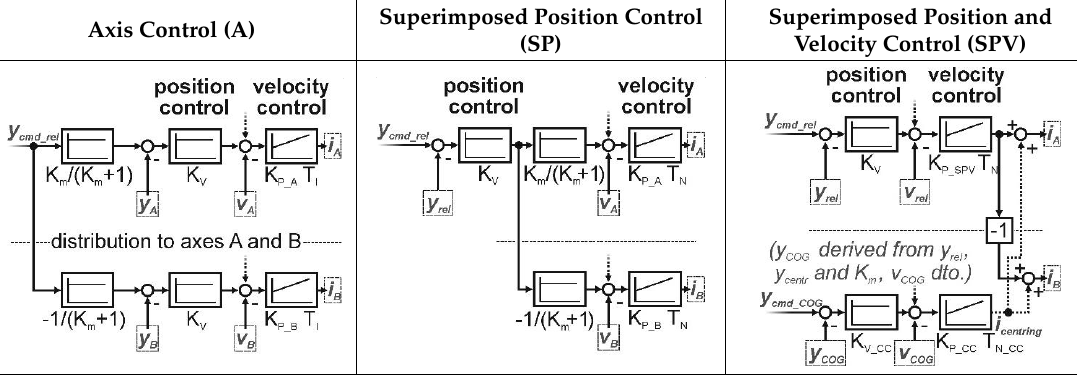
Table 2. Conventional (A) and alternative controller structures (SP and SPV) for the Kinematically Coupled Force Compensation (KCFC) axis configurations.